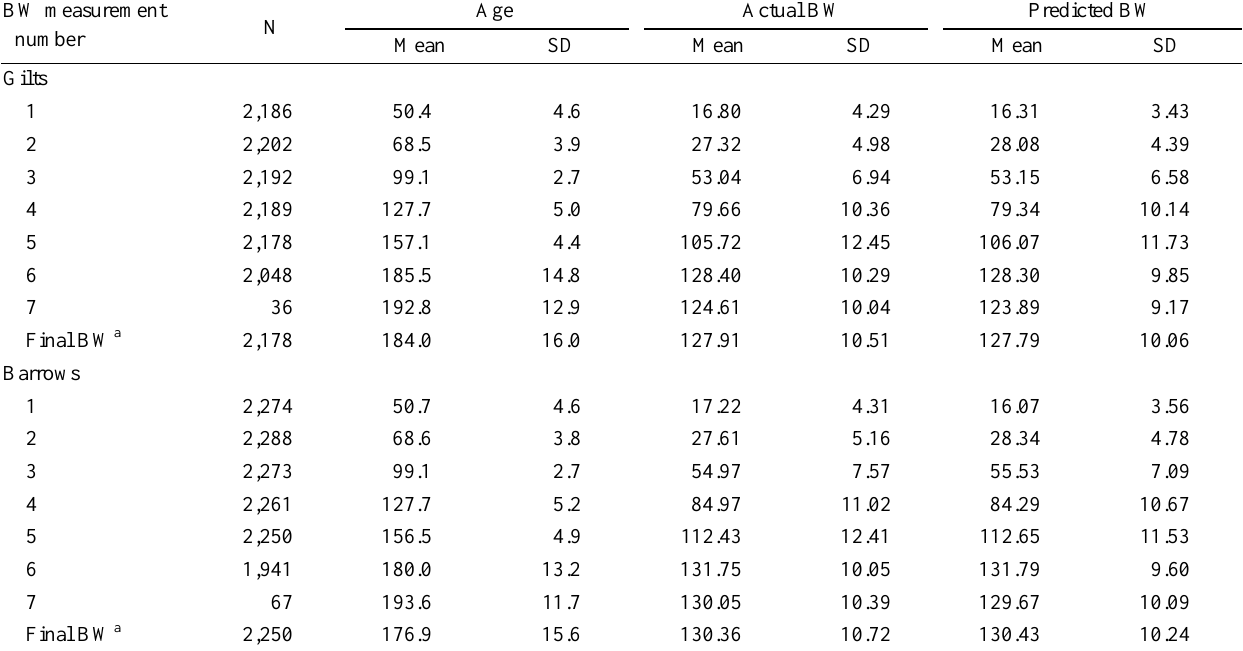
Table 4. Actual BW and SD and values predicted by the generalized Michaelis-Menten function at each time of measurement BW